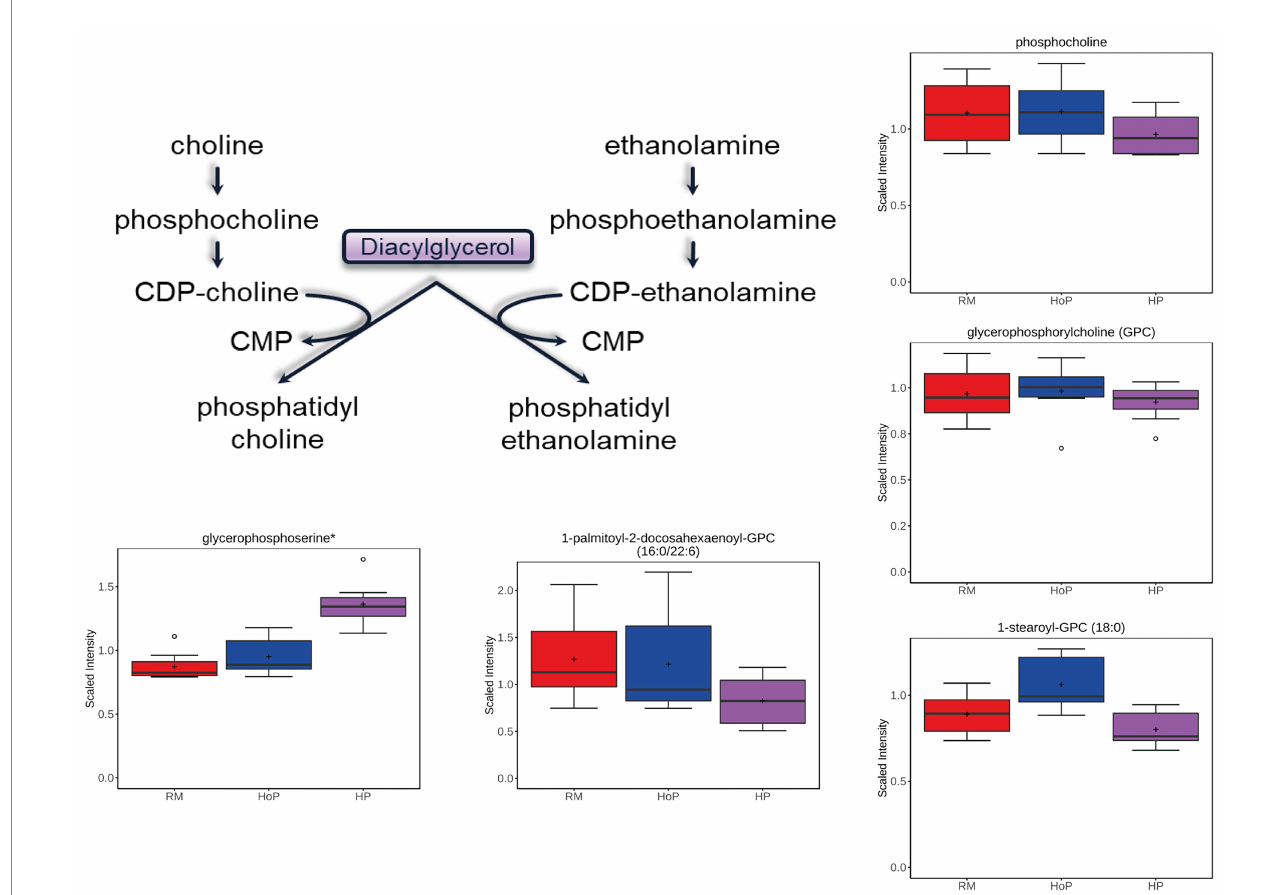
FIGURE 4 Example of milk metabolites in phospholipid metabolism significantly ( p ≤ 0.05) affected in cohort 1 by HoP or HP treatment. Phospholipid metabolism schematic diagram is indicated as well as selected boxplots for five